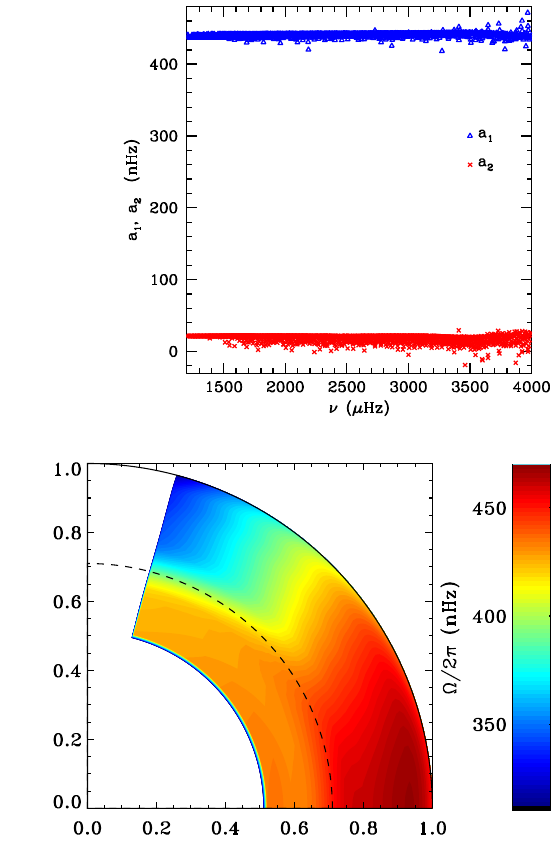
Fig. 26 The mean solar rotation profile obtained with data collected by the GONG project between mid-1995 to